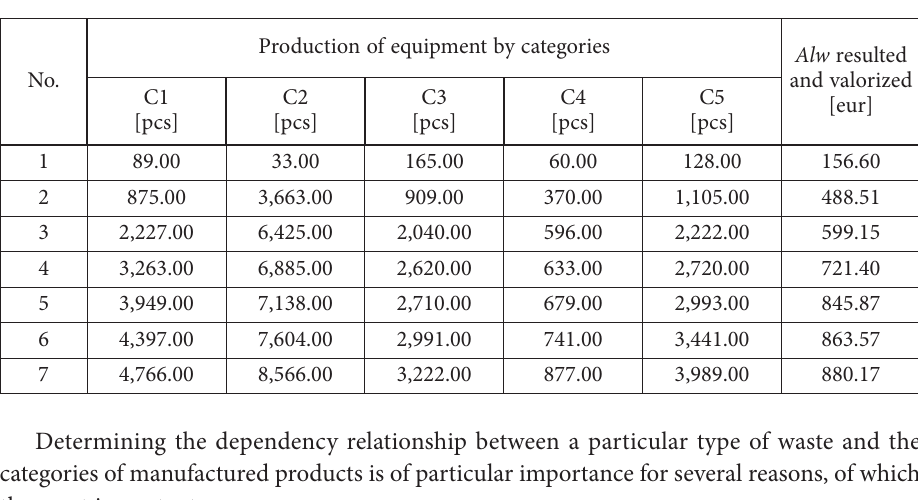
Table 8. Data used for dependency